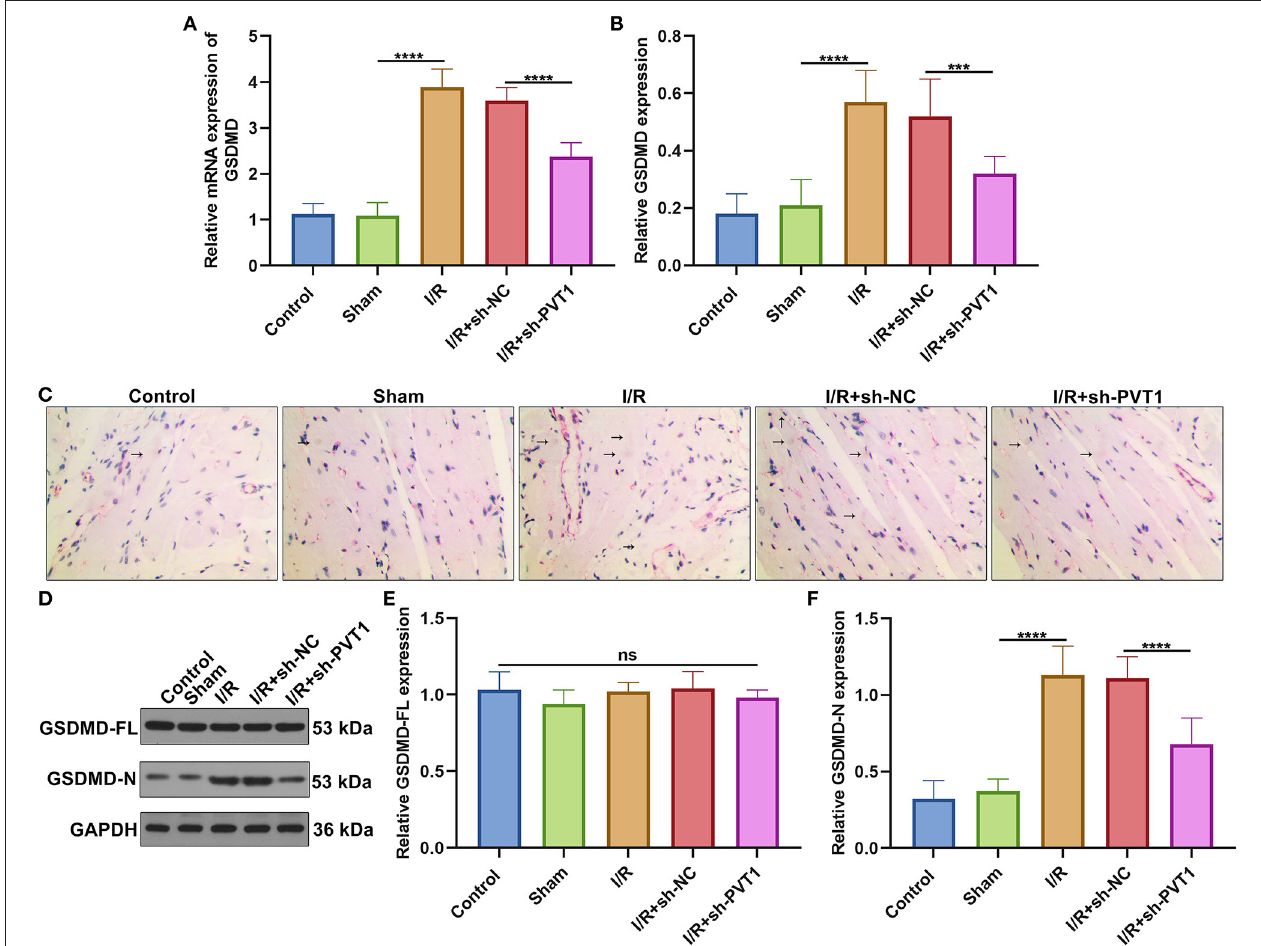
FIGURE 3 | LncRNA PVT1 knockdown alleviates GSDMD-mediated pyroptosis in myocardial I/R mice. (A) RT-qPCR of the expression of GSDMD mRNA in myocardial tissues of five groups: control, sham, I/R, I/R + sh-NC, and I/R + sh-PVT1 groups. Mice in the I/R + sh-NC and I/R + sh-PVT1 groups were injected by 10 µ L sh-NC or sh-PVT1 via Lipofectamine 2000 reagent. After 48h, myocardial I/R model was constructed. No treatment was done for mice in the control group. The chest of mice in the sham operation group was only opened, but was threaded the corresponding part without ligating the LAD. There were 10 mice in each group. (B,C) Immunohistochemistry of the expression of GSDMD protein in myocardial tissues of above groups. Arrow highlights the positive staining of GSDMD. (D–F) Western blot of (E) GSDMD-FL and (F) GSDMD-N expressions in myocardial tissues of each group. Ns: not significant; *** p < 0.001; **** p <